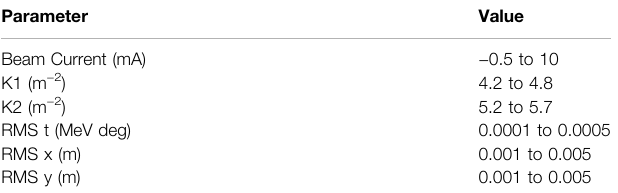
TABLE 4 | Design variables and range of their parameter space for the FODO lattice system with varying beam and cell parameters. Parameter